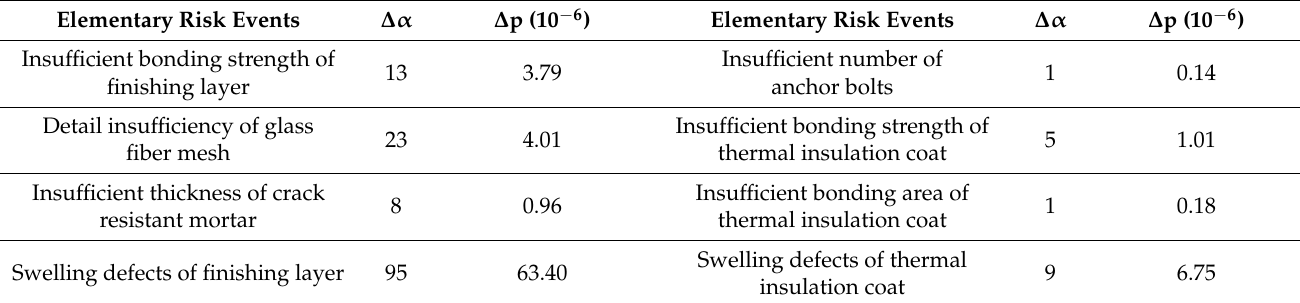
Table 4. The importance of the elementary